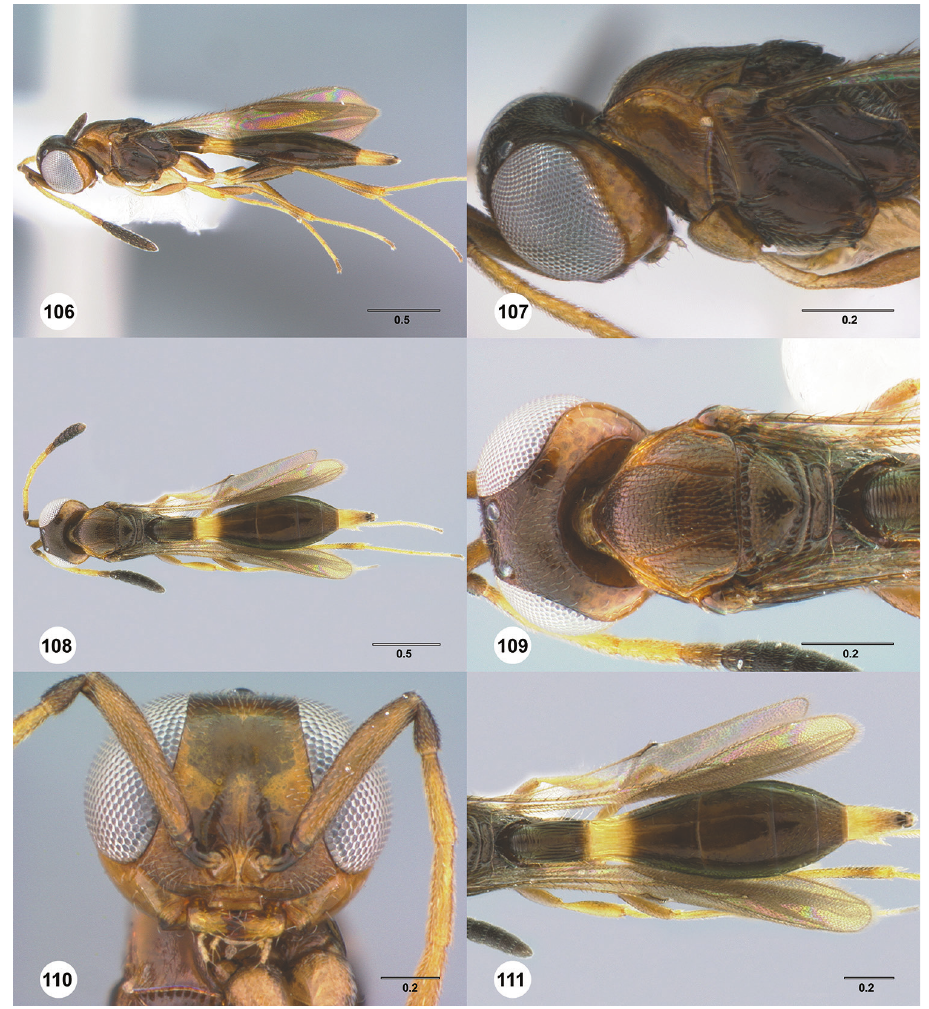
Figures 106–111. Calliscelio flavicauda sp. n., female, holotype (OSUC 553509). 106 Lateral habitus 107 Head and mesosoma, lateral view 108 Dorsal habitus 109 Head and mesosoma, dorsal view 110 Head, anterior view 111 Metasoma, dorsal view. Scale bars in millimeters. longer than wide. Form of male antennal flagellomeres: filiform, A11 approximately 3.0× longer than wide. Length of A5 tyloid in male: approximately 0.3× length of A5. Color of mesosoma in female: orange throughout; orange to pale brown; dark brown. Color of mesosoma in male: dark brown throughout. Sculpture of dorsal pro- notal area: rugose. Sculpture of lateral pronotal area: smooth throughout. Sculpture of netrion: smooth. Notaulus: percurrent or nearly so. Sculpture of mesoscutum: co- riaceous. Shape of mesoscutellum: semiellipsoidal. Foveolae of scutoscutellar sulcus between notauli: as large as those along margin of axilla. Sculpture of